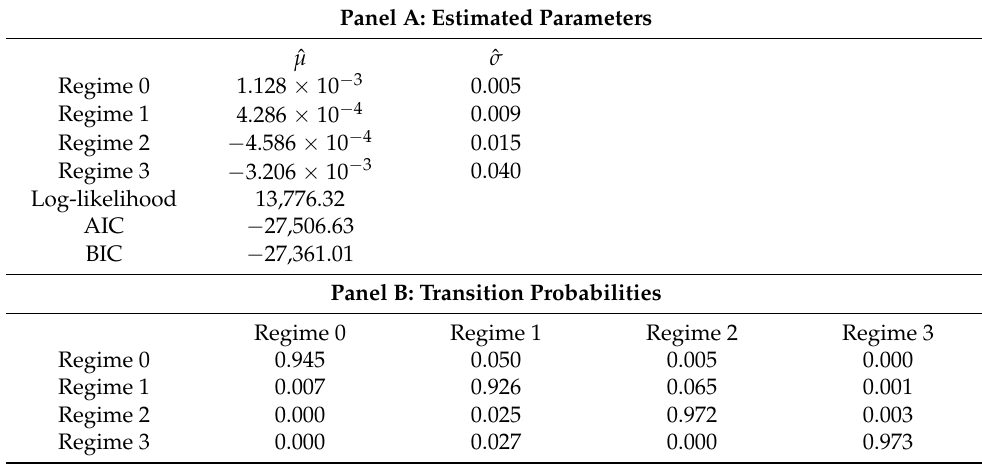
Table 9. Four-regime Markov switching models: estimated parameters for the S&P 500 index returns (years 1999–2020). AIC and BIC are the Akaike and Bayesian Information Criterion, respectively.